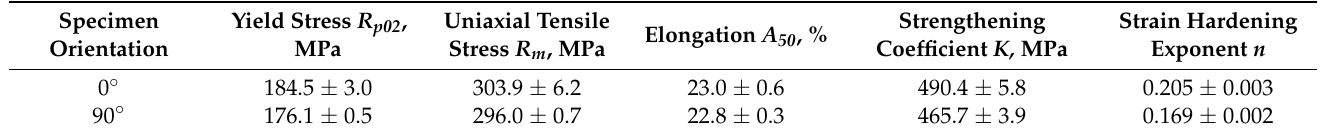
Table 1. Basic mechanical parameters of the DC04 sheet metal ( ± standard deviation).